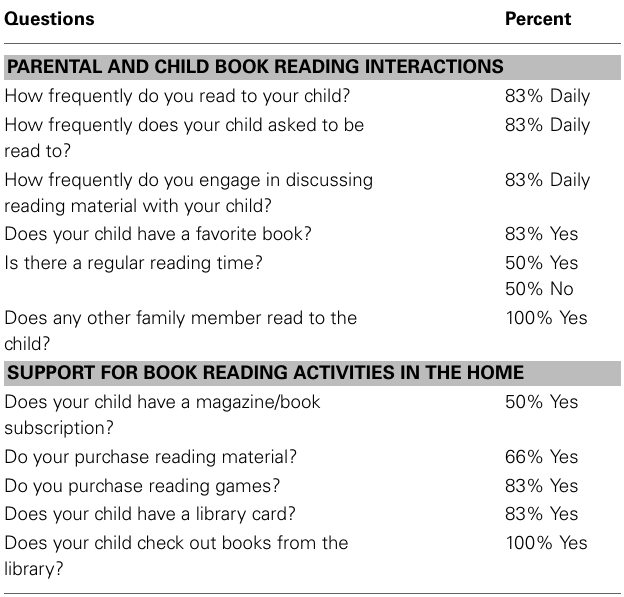
Table 1 | Parental support for reading activities in the home